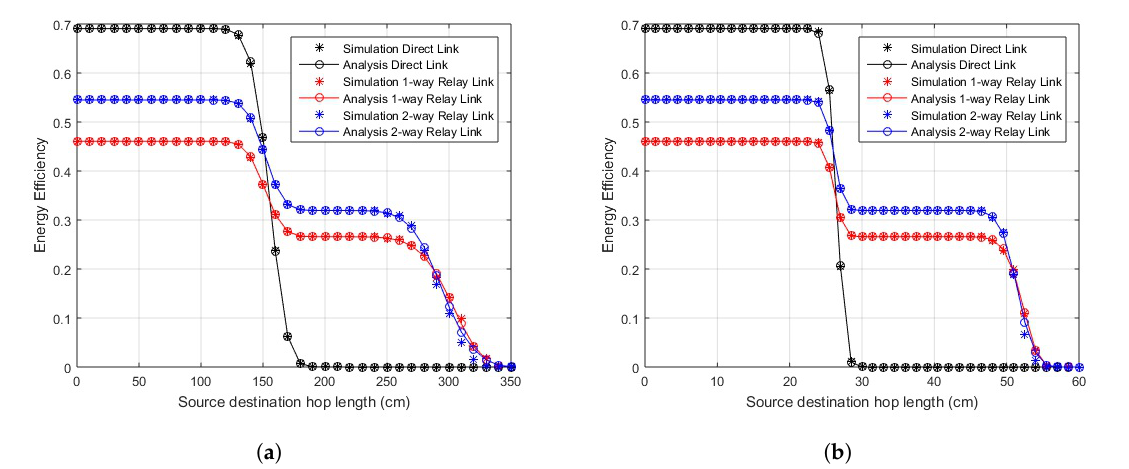
Figure 4. Energy efficiency over distance (in-body communication).